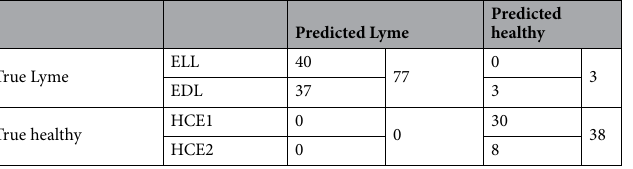
Predicted healthy